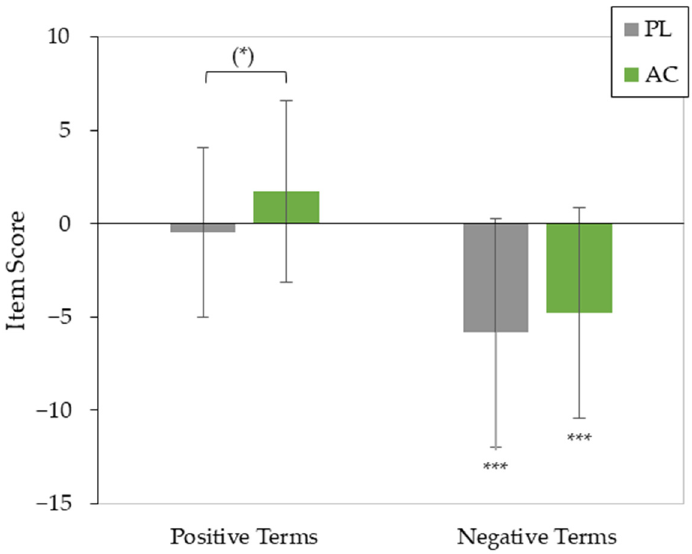
Figure 3. Changes (after versus before product application) for the positive and negative items of the Positive and Negative Affect Schedule (PANAS) for the samples placebo (PL) and active compound (AC) (mean ± SD). Note: (*) Trend towards statistical significance with p < 0.1. *** Significance with p < 0.001.